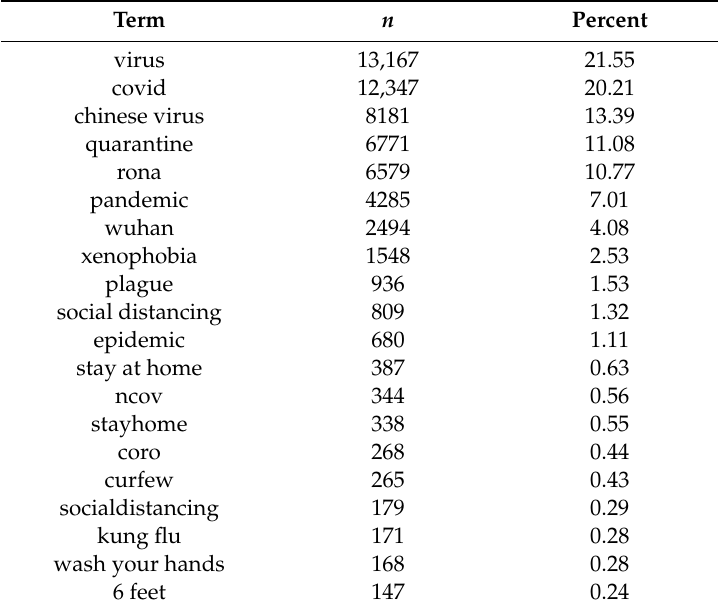
Table 3. Top COVID-19 related terms invoked in Tweets mentioning a race-related term,